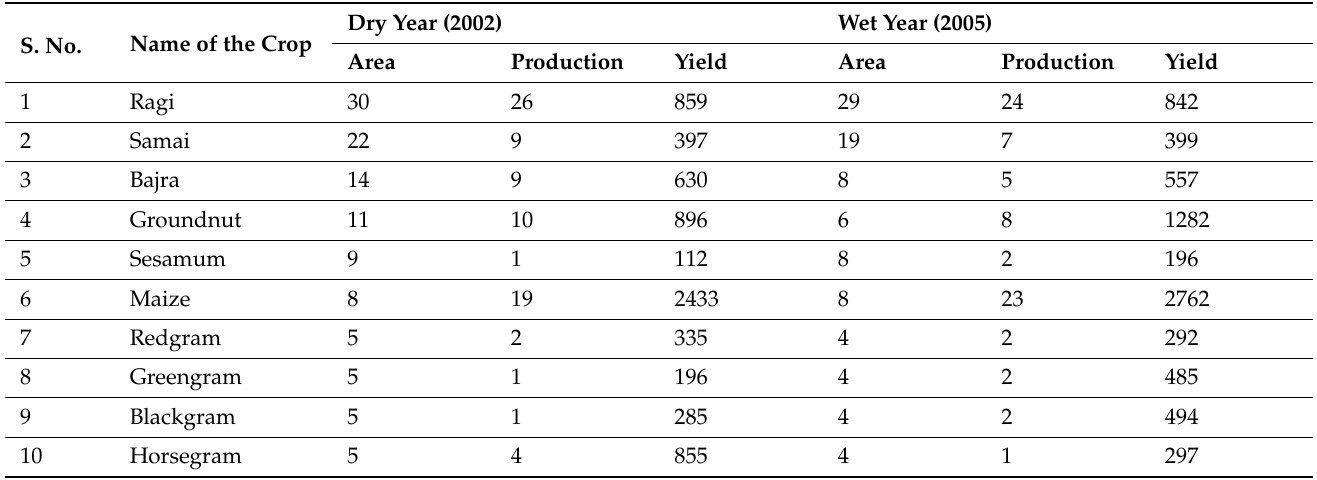
Table 2. Area, production, and yield during dry and wet years in hectares.